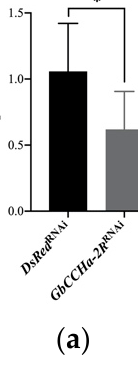
Figure 2. RNAi efficiency. The relative mRNA levels of GbCCHa-2R in CNS ( a ) and gut ( b ) on the third day after dsRNA injection. ß-actin was used as the reference gene. Values are shown as mean + S.D., n = 5–9, * p < 0.05, ** p < 0.01, unpaired t